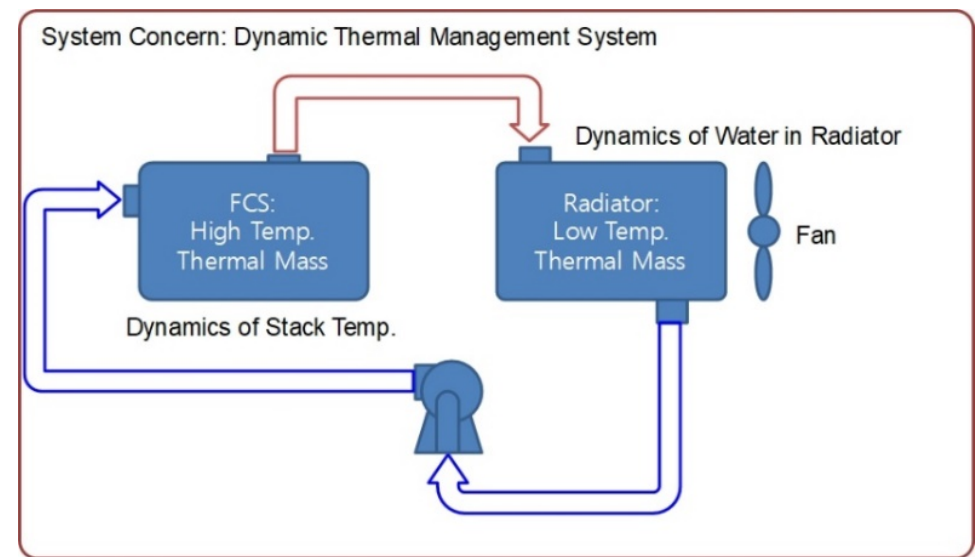
Figure 3. Dynamic thermal management system for sensor fault diagnosis.